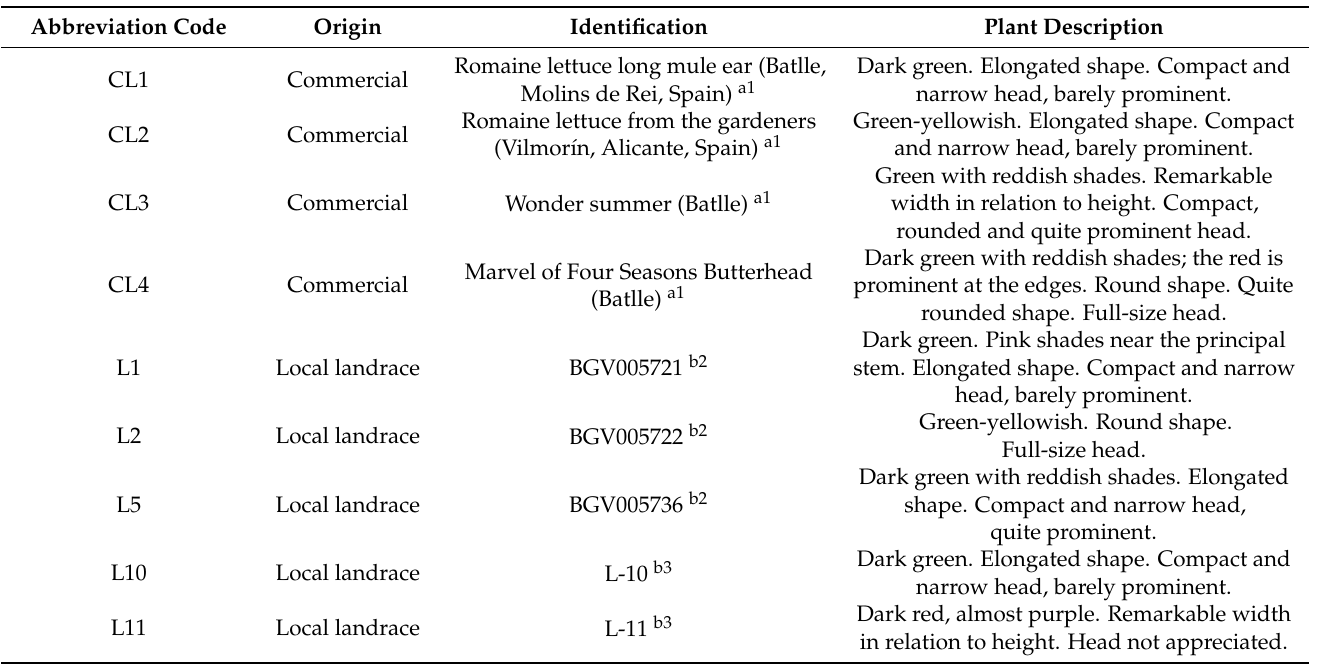
Table 1. The abbreviation, origin, identification and short phenotypic description of the nine lettuce varieties herein used. Plant material was provided by: (1) a commercial company; (2) the Institute for the Conservation and Improvement of Valencian Agrobiodiversity (COMAV, Valencia, Spain); (3) the Valencian Institute for Agricultural Research (IVIA, Moncada,